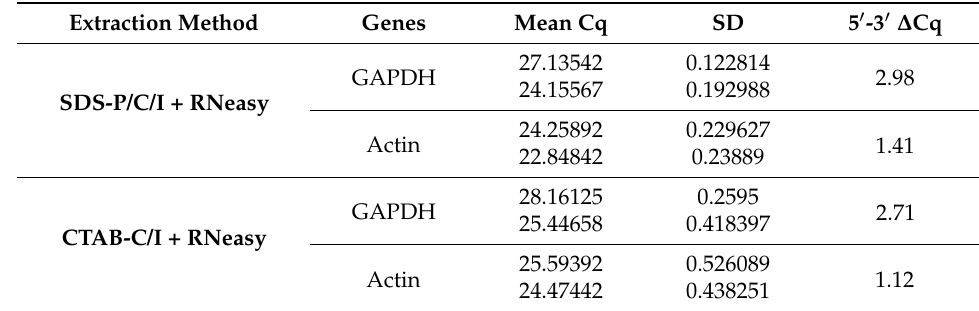
Table 2. The 5 1 -3 1 ratio mRNA integrity test. The test was carried out using primers designed on the 5 1 and 3 1 regions of GAPDH and actin genes from hemp ( n = 4). The mean Cq values for each gene correspond, in the order shown, to the 5 1 and 3 1